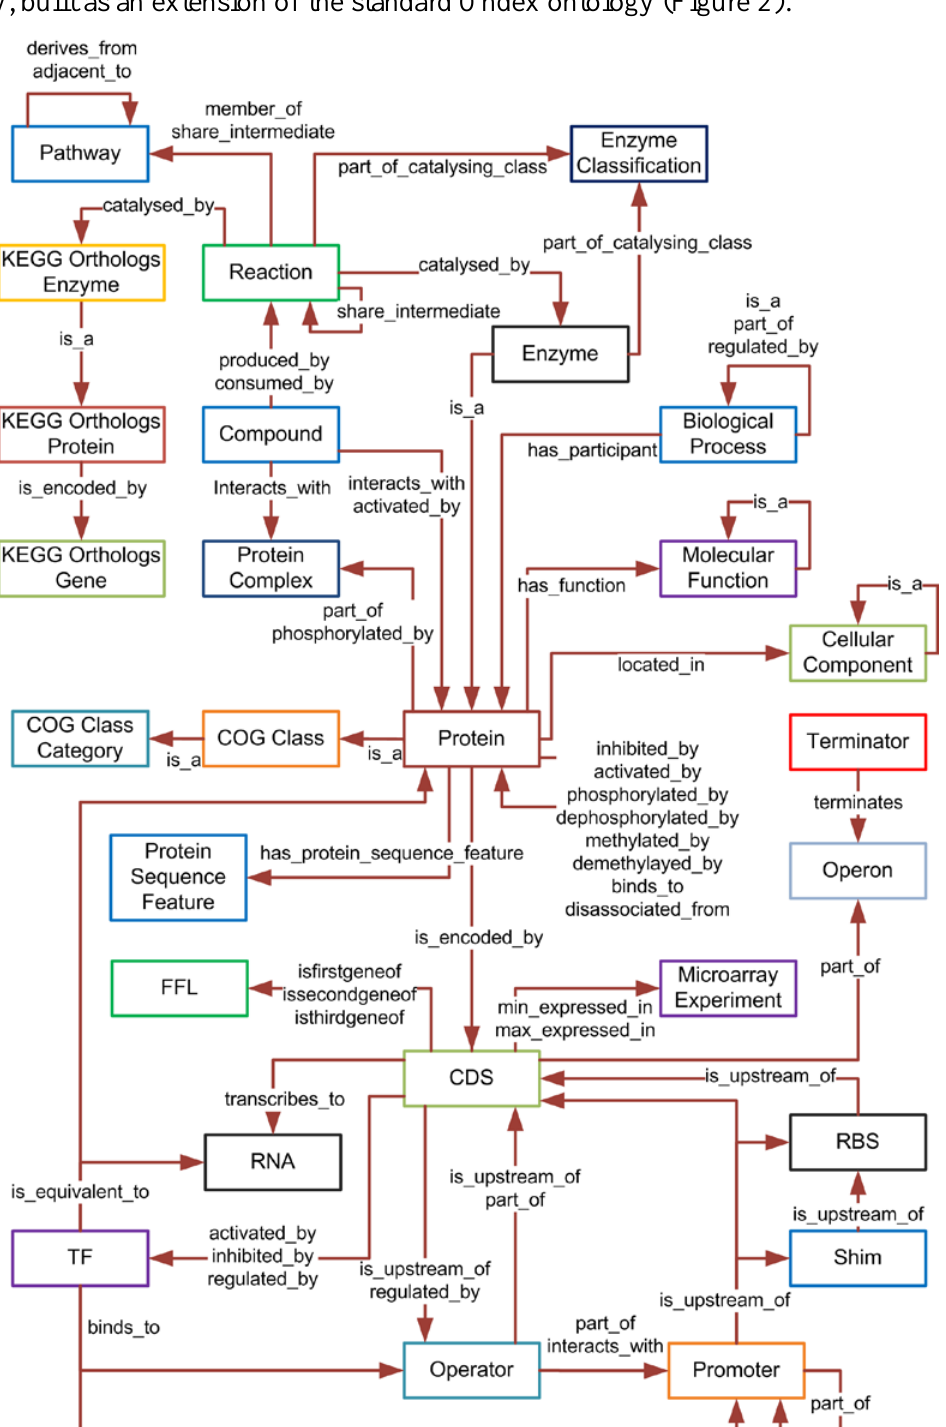
Figure 2. The BacillOndex